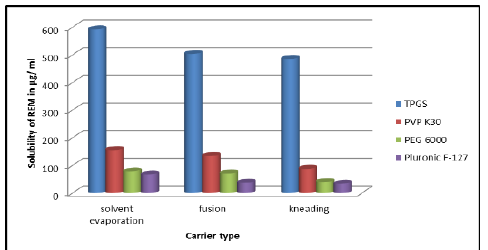
Figure 2. Effect of carrier type of REM solid dispersion at ratio (1:9) on the solubility of REM in distilled water at 25°c (results are expressed as mean, n=3)